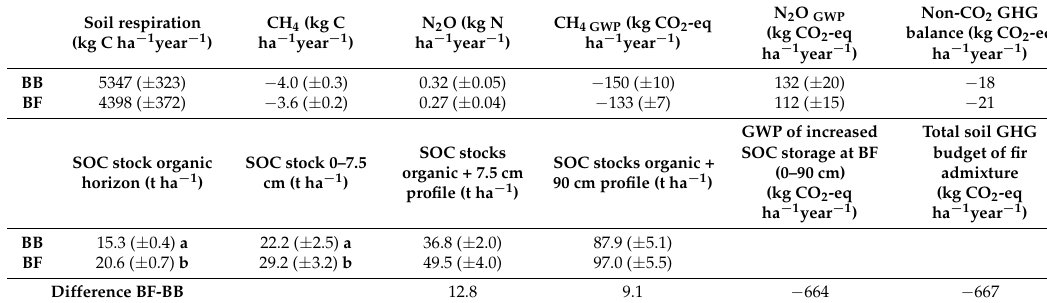
Table 1. The annual cumulative flux rates (March 2016–March 2017) of soil respiration (CO 2 ), CH 4 and N 2 O; the related global warming potentials (GWP) of CH 4 and N 2 O; and the non-CO 2 greenhouse gas (GHG) balance of soils of the pure beech (BB) and mixed beech-fir stand (BF) stands; mean ( ± se). Furthermore, the soil organic carbon (SOC) stocks for the organic horizon and the top mineral soil (0–7.5 cm) as well as for the entire soil profile are presented ( n = 3, mean ± se). Indices indicate significant differences within the horizon ( p < 0.05). The annual SOC stock changes (SOC stocks GWP) due to fir admixture are calculated for a stand age of 50 years. These data are merged with changes in non-CO 2 GWP due to fir admixture to calculate the total soil GHG budget. Soil respiration (kg C ha − 1 year − 1 )